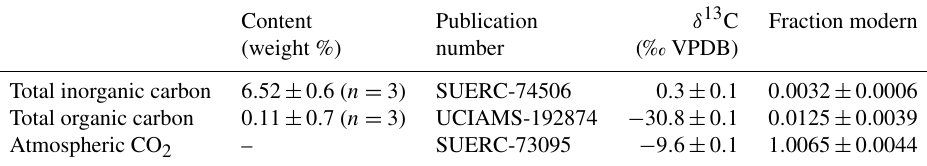
Table 3. Geochemical compositions of the end-members involved in the isotopic mass balance (Eq. 6) were measured from the rock sampled during the drilling of chamber H6 ∗ , and from an atmospheric CO 2 sampled actively with a zeolite molecular sieve (Table